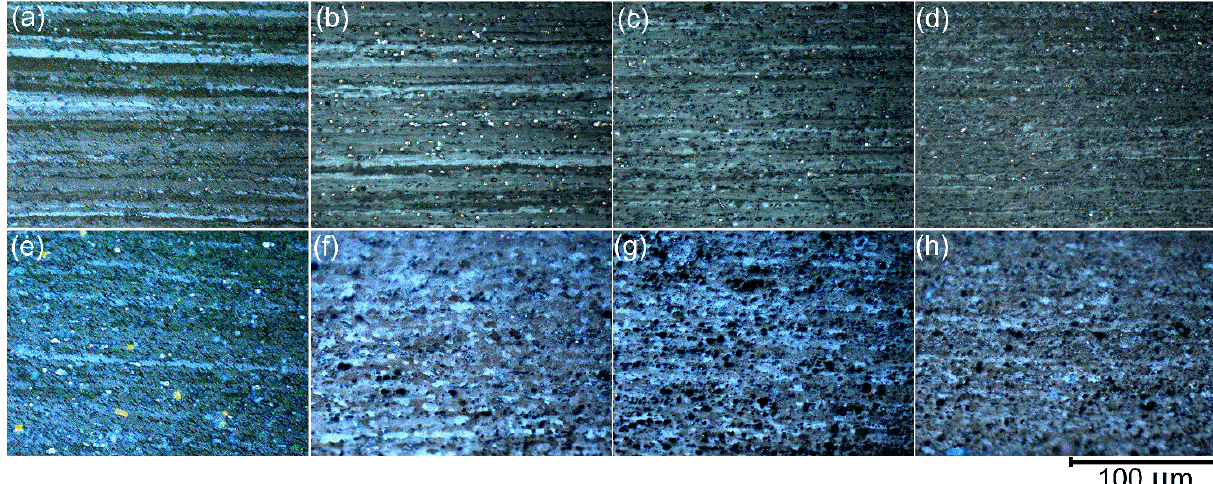
Figure 9. The grain structure for the ( a , e ) reference Ni-free alloy, ( b , f ) alloy 1 (Al-1.2Mg-0.7Si-1.0Cu-0.5Ni), ( c , g ) alloy 2 (Al-1.2Mg-0.7Si-1.0Cu-2Ni), and ( d , h ) alloy 3 (Al-1.2Mg-0.7Si-1.0Cu-4Ni) after the thermomechanical treatment and final annealing at ( a – d ) 500 °C for 20 min and ( e – h ) 300% of strain at 460 °C and constant strain rate of 5 × 10 −3 s −1 .